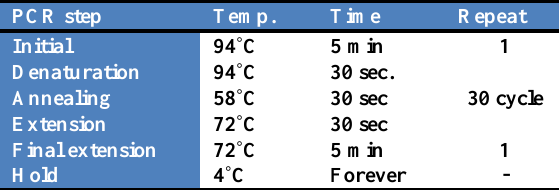
Table, 3: PCR thermocycler conditions .